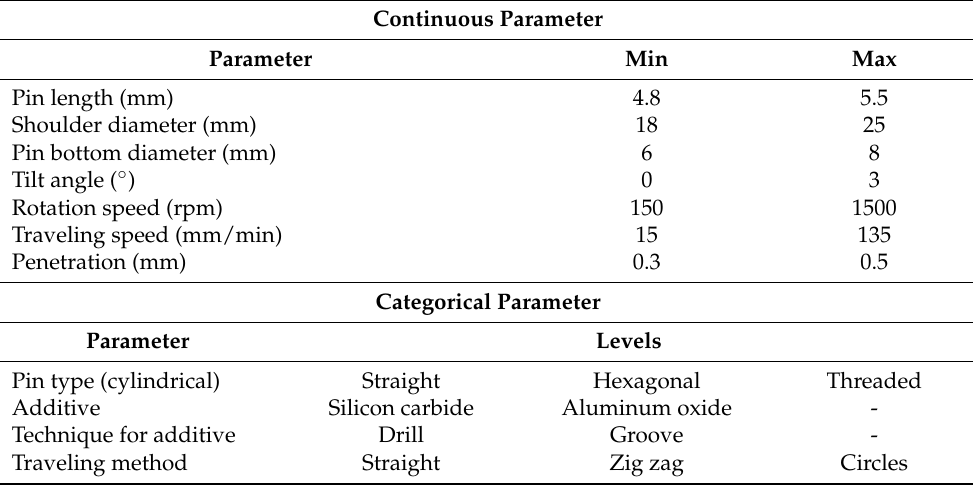
Table 1. Details of the parameters used to prepare the